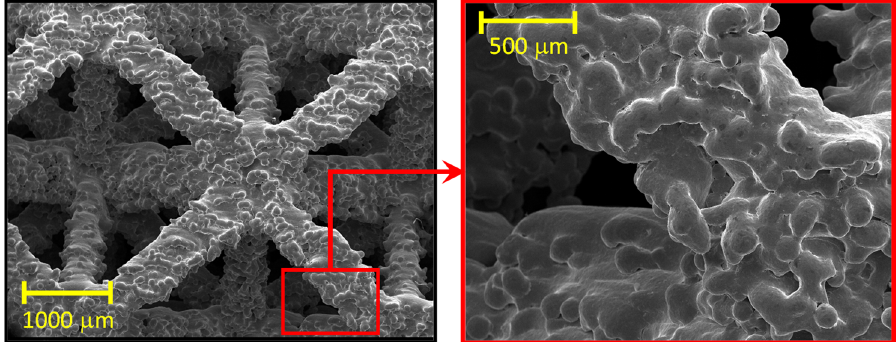
Figure 14. A micrograph of the lattice structure, denoting the surface roughness of trusses.